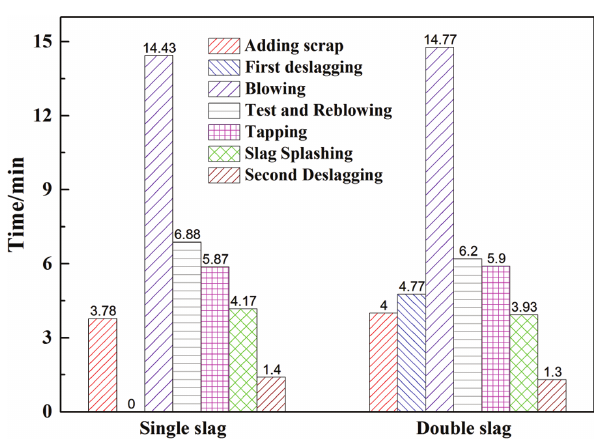
Figure 14: Comparison of smelting time between single- and double- slag